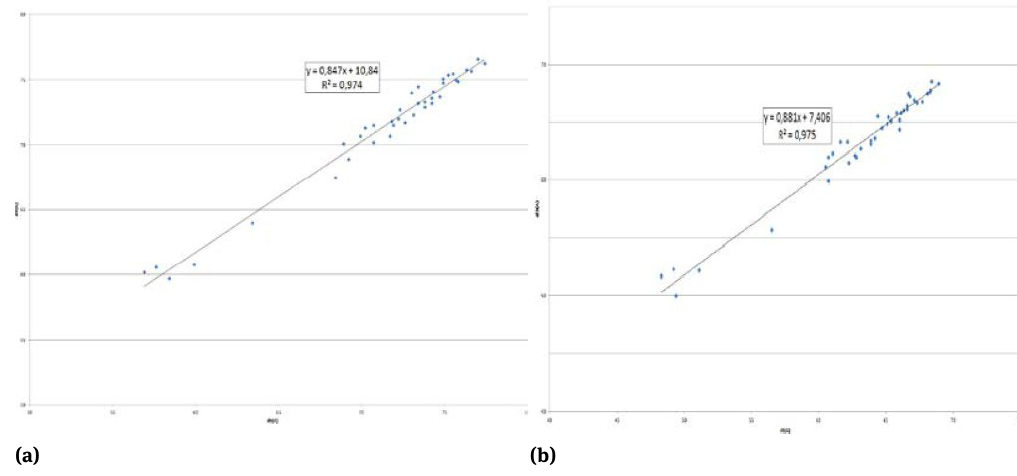
Fig. 8. Herakleion SNM 2012 Measured vs calculated values R 2 : (a) Noise index L den (b) Noise index L night ) .